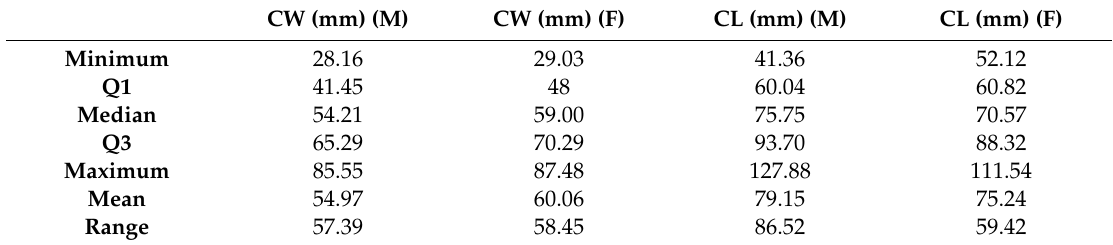
Table A1. Minimum, median, average and maximum values of CW and CL regarding the spiny lobsters’ measurements, from the Thermaikos Gulf, 2017.